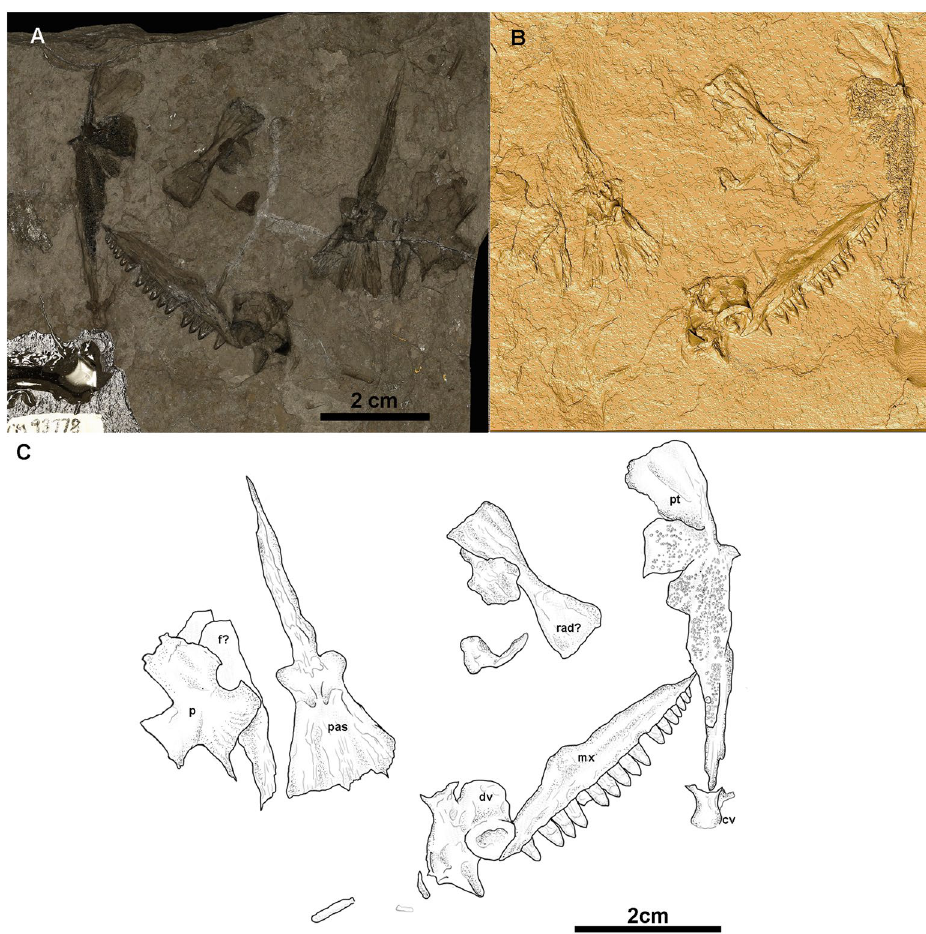
Figure 2. Melanedaphodon hovaneci gen. et sp. nov., CM 93779. ( A ) Photograph showing the negative relief/ natural mold. ( B ) Digital three-dimensional rendering of the CT data in positive relief. ( C ) Interpretative drawing based on the CT scans and original fossil. Anatomical abbreviations: cv caudal vertebra, f frontal, mx maxilla, p parietal, pas parabasisphenoid, pt pterygoid, rad radius, dv dorsal